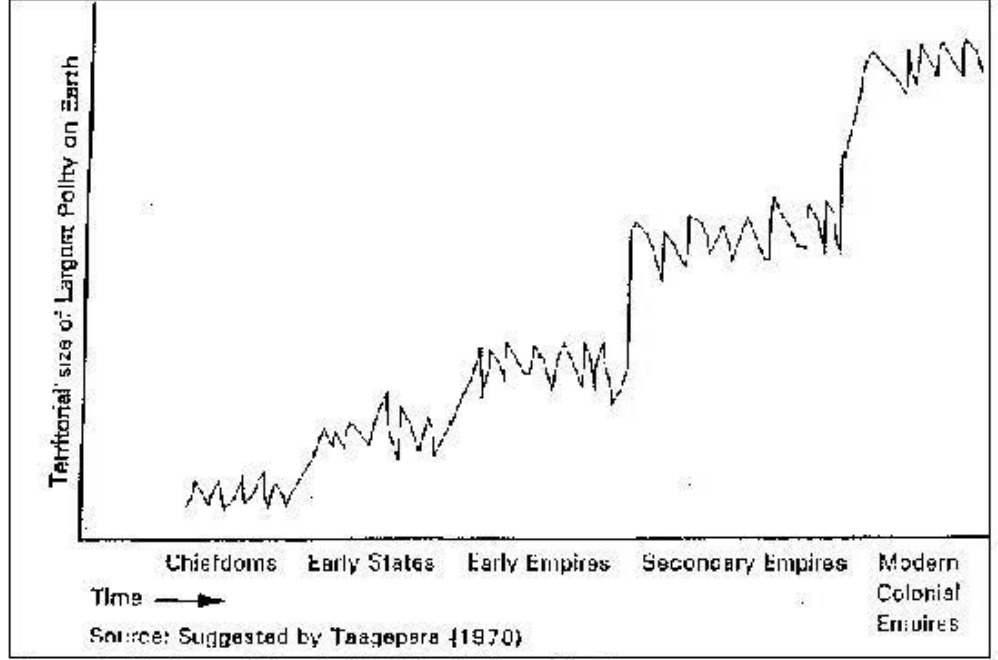
figure:\. Cycles and Treml of Political